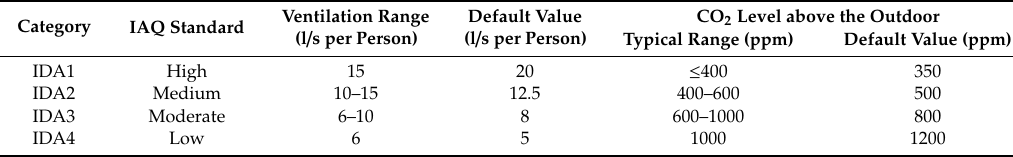
Table 1. Definition of indoor air quality (IAQ) standards.